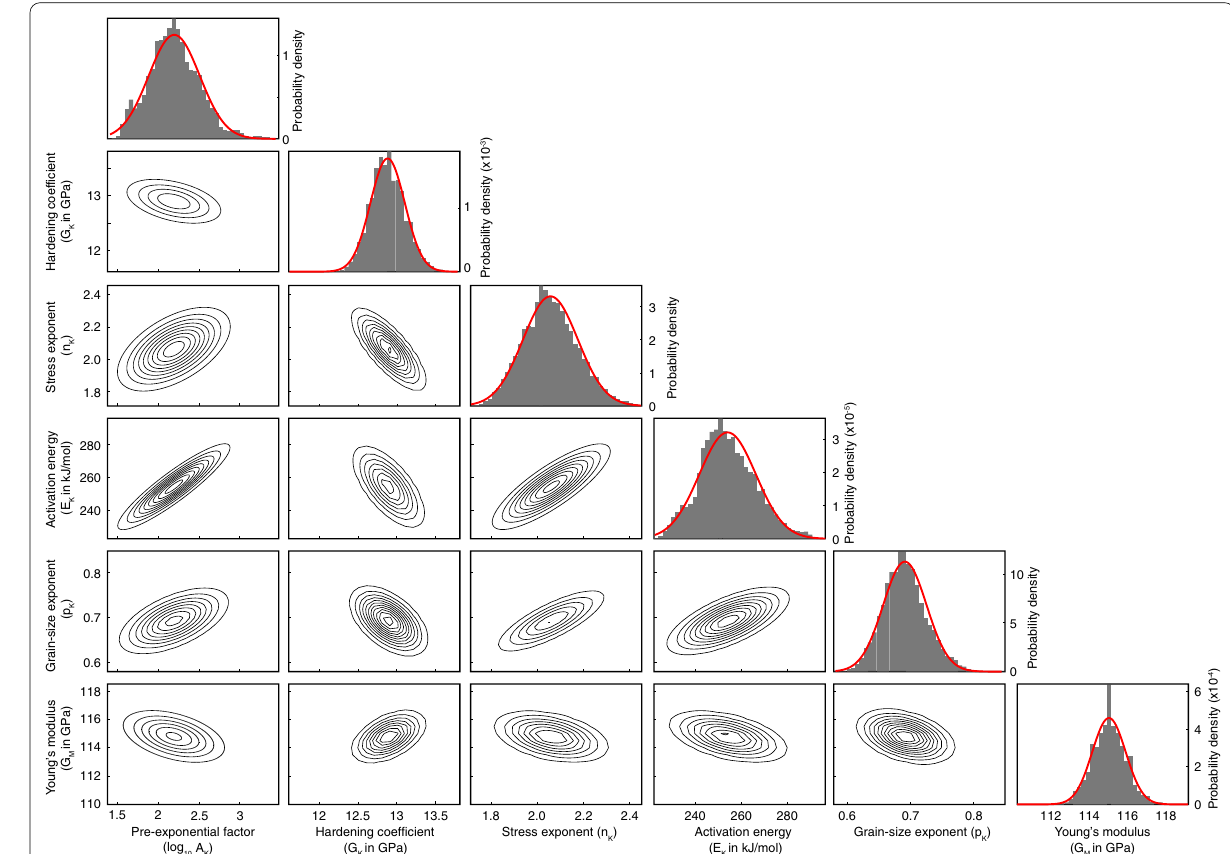
Fig. 7 Joint and marginal distributions of the flow law parameters for the transient creep of dunites under hydrous conditions generated from Gibbs sampling. The nonlinear Burgers model is modified to include the grain size and its exponent p